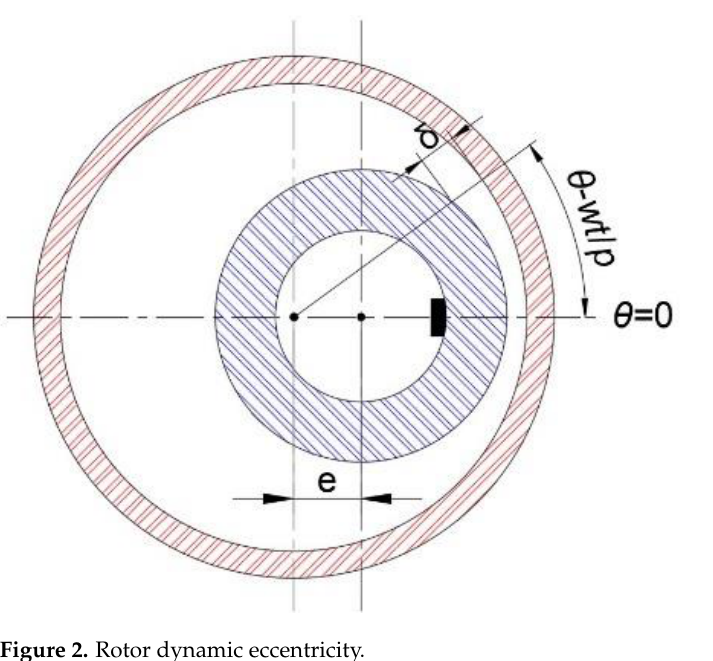
Figure 2. Rotor dynamic eccentricity.